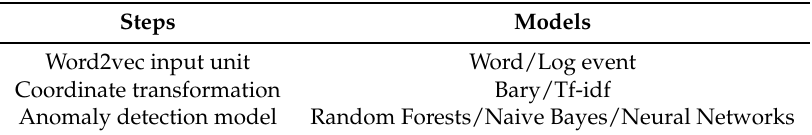
Table 5. The component of comparison